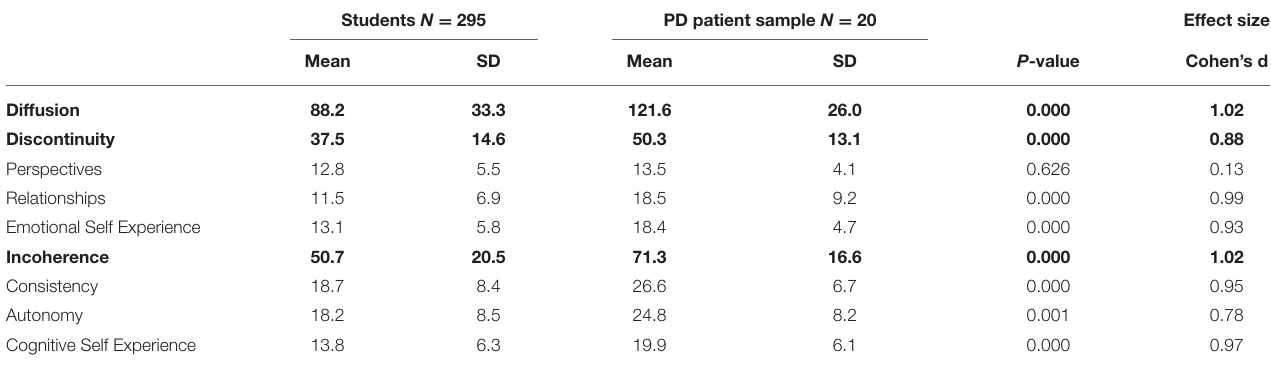
TABLE 5 | Differences in AIDA mean scores (mean) and standard deviations (SD) between students and PD patients; significance (p) and effect size Cohen’s d. Students N = 295 PD patient sample N = 20 Effect size Mean SD Mean SD P -value Cohen’s d